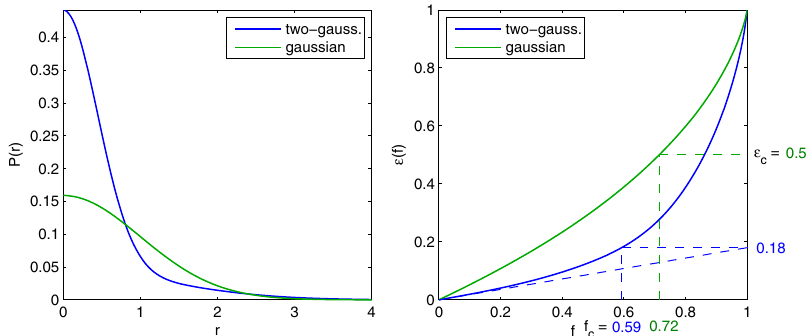
FIG. 9. Radial phase-space distributions (left) and corresponding emittance vs fraction curves (right). Both distributions are scaled to have (cid:7) ¼ 1 . Core fraction and emittance for the two distributions are shown as well.